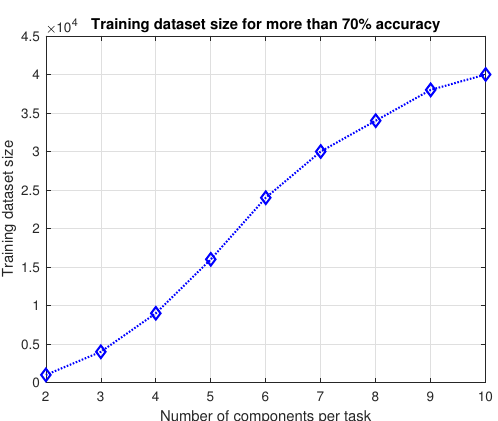
Figure 5. Training dataset size for different number of components with more than 70% accuracy. Similarly, the effect of the number of components per task on accuracy is shown in Figure 6. As the number of components per task increases, the possible number of offload- with minimum cost decreases and the performance of TOT and ROT decreases. While